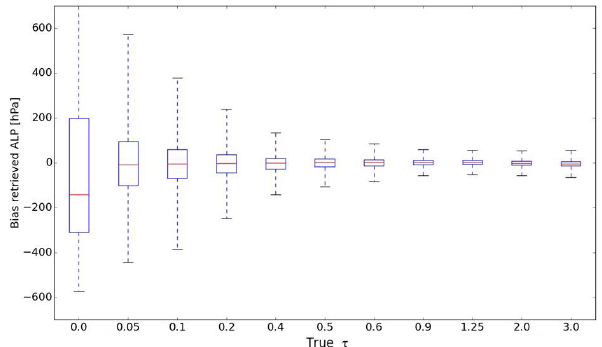
Figure 7. Box–whisker plots of retrieved aerosol layer pressure (ALP) biases as a function of true τ( 550nm ) from NN R configuration over the whole learning data